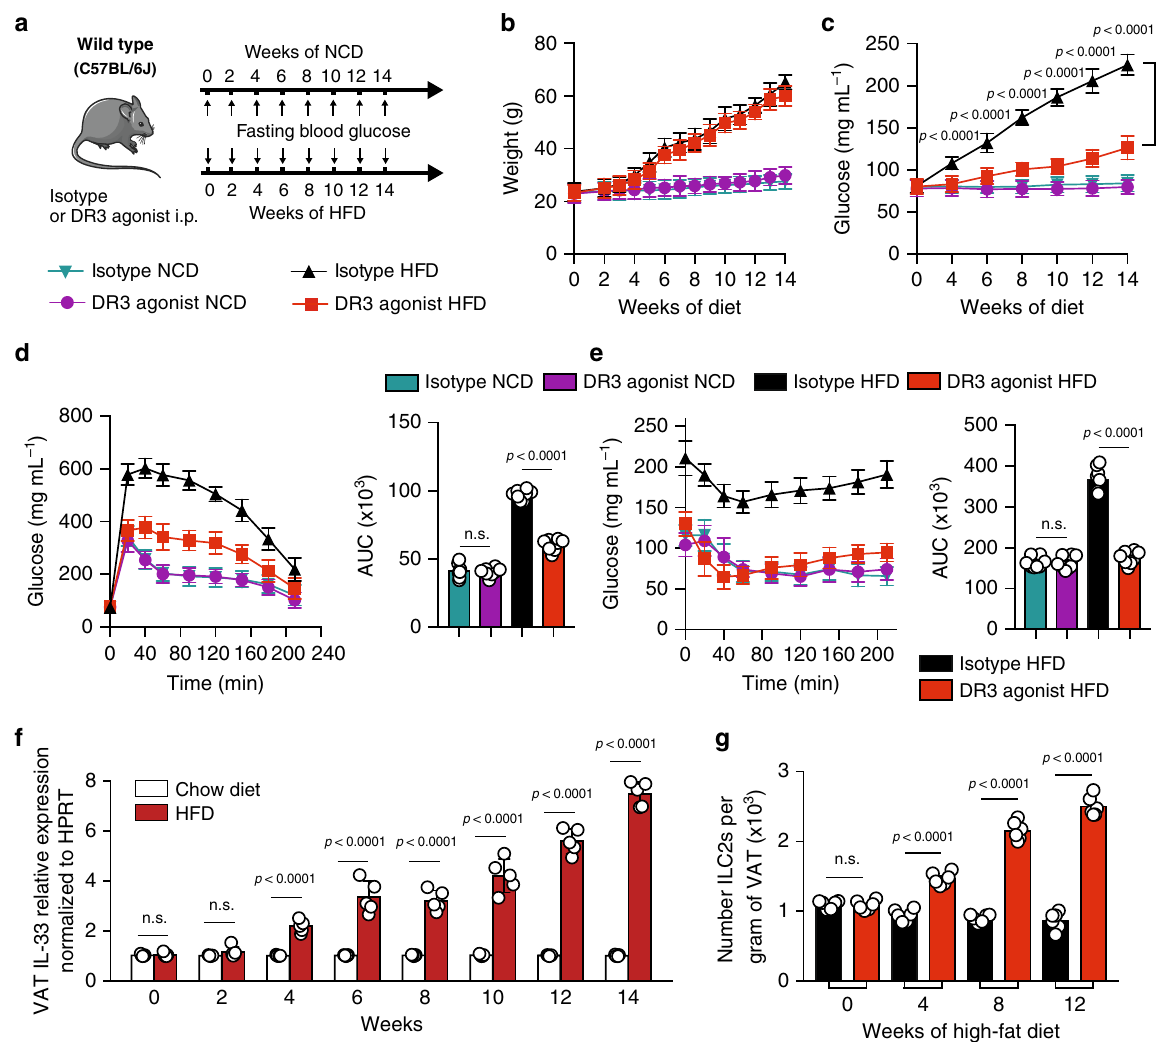
Fig. 2 DR3 stimulation allows for protection from the onset of type 2 diabetes in WT mice. a As shown in the timeline, a cohort of C57BL/6J mice were fed a normal chow diet (NCD) or a high fat diet (HFD) and treated with either DR3 agonist (1 mg/mouse) or isotype control via intraperitoneal injections (i. p.) every four days, n = 8 mice. b The total weight of the mice was measured once every week, and c the fasting blood glucose levels were measured once every two weeks for a period of 14 weeks. d Glucose tolerance test, and e insulin tolerance test were performed on the 14th week on the treatment. The corresponding area under the curve (AUC) was calculated for each cohort. f Time-kinetic qPCR expression of IL-33 in VAT lysate. g The number of VAT ILC2s in HFD-fed mice throughout the treatment course with DR3 agonist or isotype. Error bars are the mean ± SD. Statistical analysis, one-way ANOVA ( b , c ), two-way ANOVA ( d , e ), two-tailed student ’ s t -test (f and g); n.s.: p -value of <0.05 was considered as non-signi fi cant. Mouse image provided with permission from Servier Medical